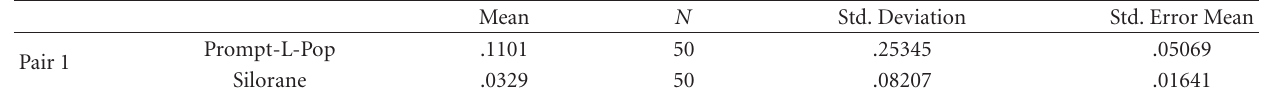
Table 4: Paired samples statistics.